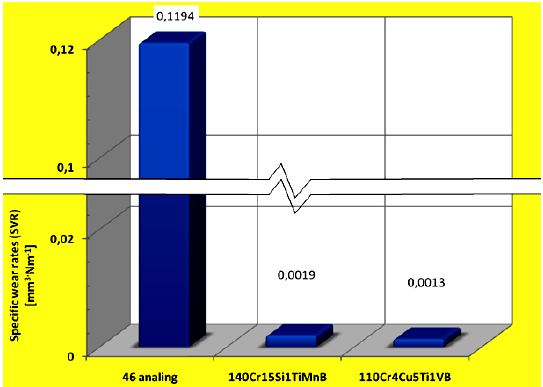
Figure 3. Two-body abrasive wear of deposited metals.